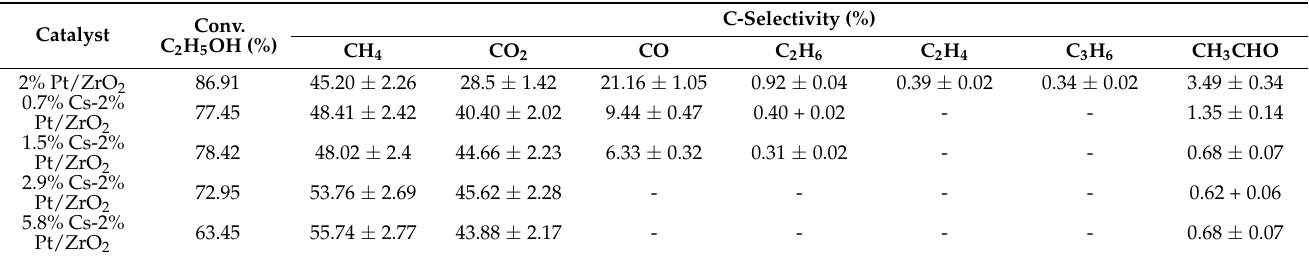
Table 4. ESR activity for different Cs loading (300 ◦ C, 1 atm, 19,0560 Ncc/h/g cat , feed: C 2 H 5 OH 2.98%/H 2 O 26.14%/N 2 70.88%).